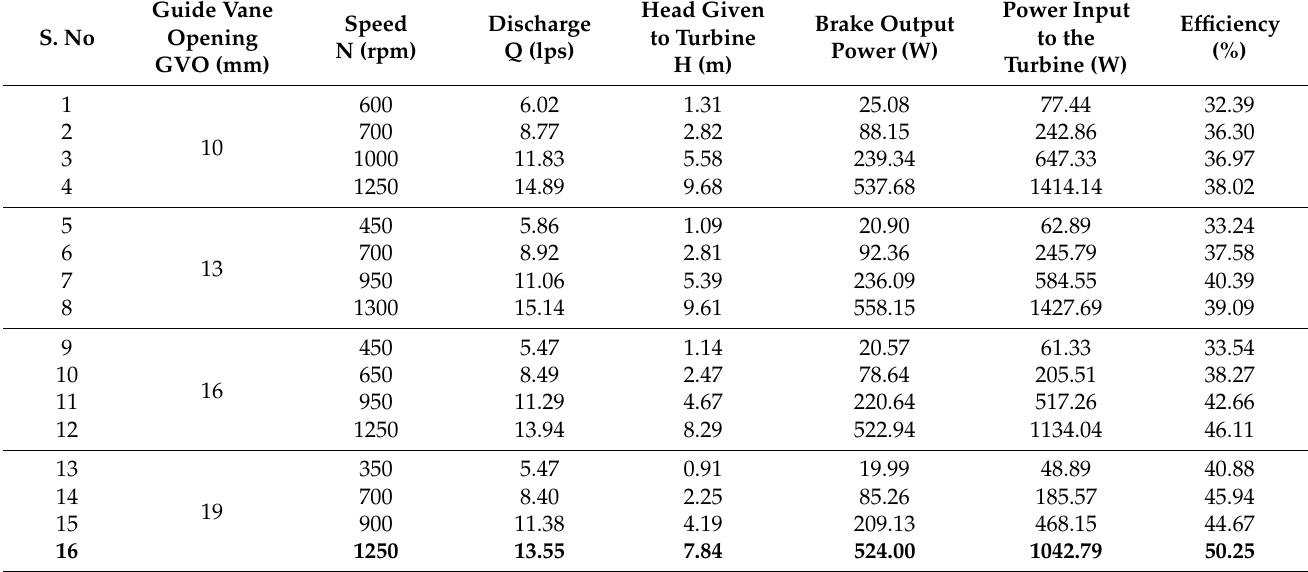
Figure 37. BEP unit quantities vs. GVO. Table 1. Best efficiency points from characteristics of Francis turbine.